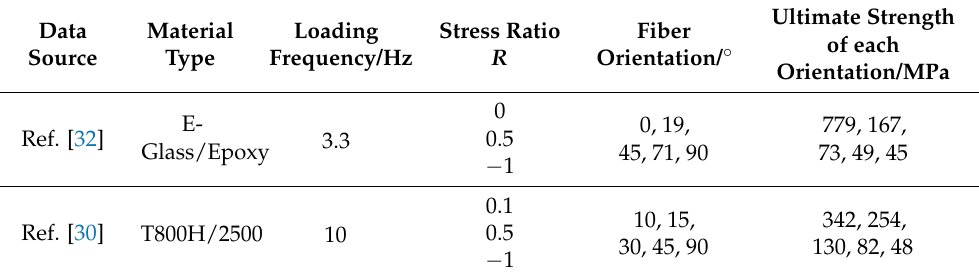
Table 2. Fatigue test conditions for unidirectional laminates with different fiber orientations.